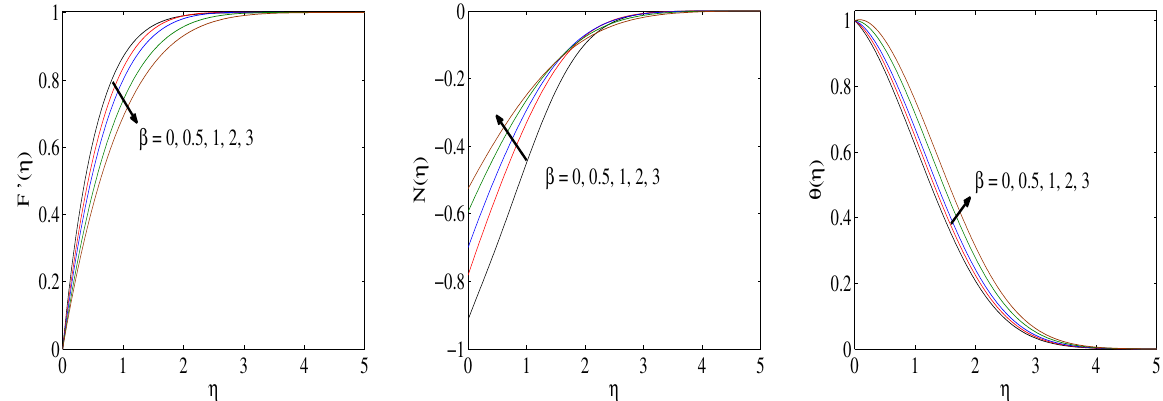
Figure 2. Velocity and angular velocity distribution under the impact of β factor.